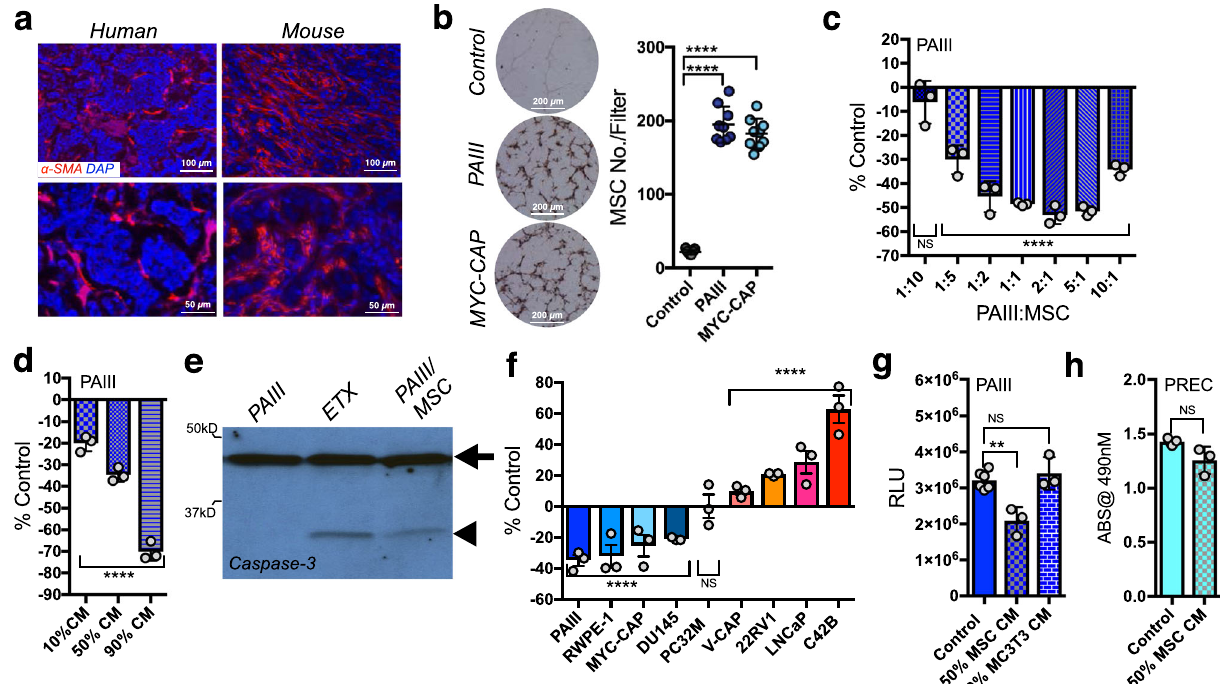
Fig. 1 Bone marrow-derived MSC effects on prostate cancer cells. a Representative images ( n ≥ 3 biologically independent samples) of α -Smooth muscle actin (SMA) staining of human and rodent bone metastatic prostate cancer. b MSC migration to prostate cancer cell conditioned media. Number of hematoxylin and eosin stained MSCs per fi lter (MC No./Filter; n = 3 fi elds of view from n = 3 biologically independent samples) were counted after 6 h of incubation. Representative photomicrographs of fi elds of view are shown. c Direct co-culture of MSCs and PAIII prostate cancer cells at various ratios of PAIII:MSC. Values calculated as percentage of respective PAIII controls seeded at the same density (% Control). Growth was determined by luminescence assay and relative light unit (RLU) measurement. d MSC conditioned media (CM) treatment of PAIII at varying ratios. Final concentration of serum was 10% for each condition. e Cleaved caspase-3 (arrow head) in PAIII cells treated for 6 h with MSC CM (50% ratio). Arrow indicates full-length caspase-3. Etoposide (ETX; 50 μ M) was used as a positive control. These experiments were repeated twice with similar results. f MSC CM (50%) effects on prostate cancer cell line growth, relative to untreated controls. Growth measurements were performed by MTT or luminescence assay. g PAIII treated with MSC or osteoblast (MC3T3) CM. h Prostate epithelial cells (PREC) treated with MSC CM. MTT absorbance (ABS) was used as a readout for cell growth. Statistical analyses used include unpaired t -test ( c , d and f – h ) and ANOVA with multiple comparisons at 95% CI ( b – d and f , g ) with error bars representing the mean ± SD. All experiments were independently repeated ( n = 3). Asterisks denotes statistical signi fi cance (* p ≤ 0.05, ** p ≤ 0.01, *** p ≤ 0.001, **** p ≤ 0.0001) while NS denotes not signi fi